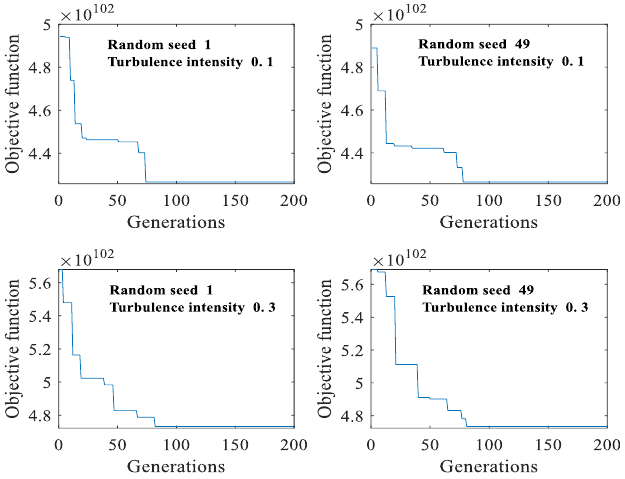
Figure 7. The change curve of the objective function.